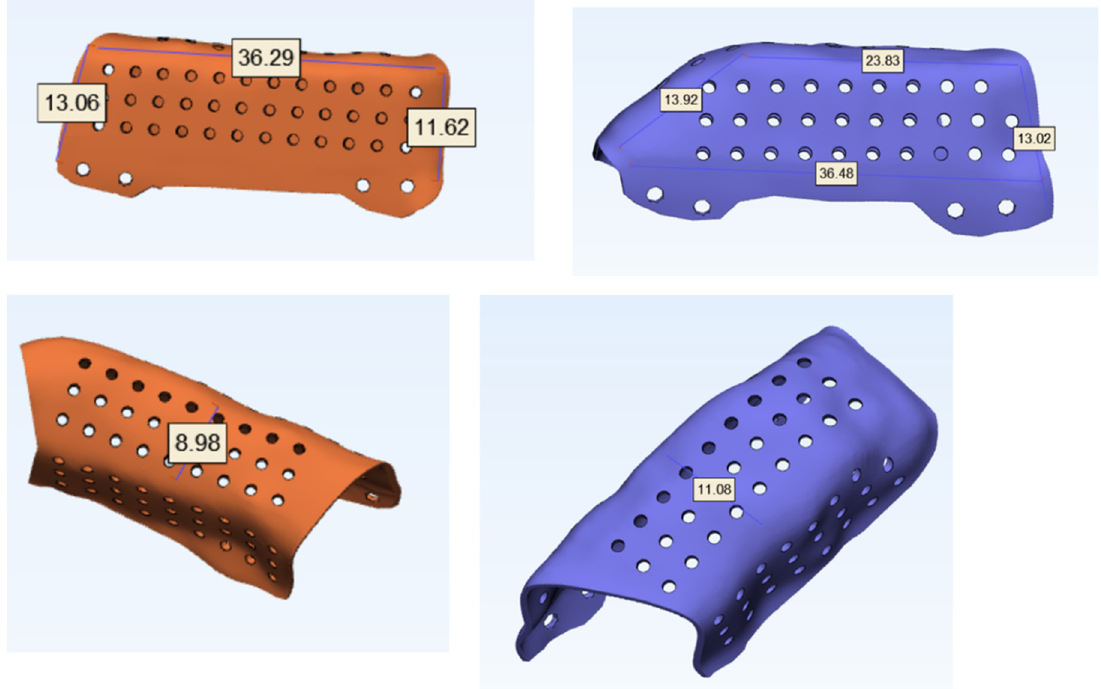
Figure 3. Vertical and horizontal dimensions of titanium customized meshes (CAD/CAM). Mesh porosity to allow for revascularization and bone regeneration.